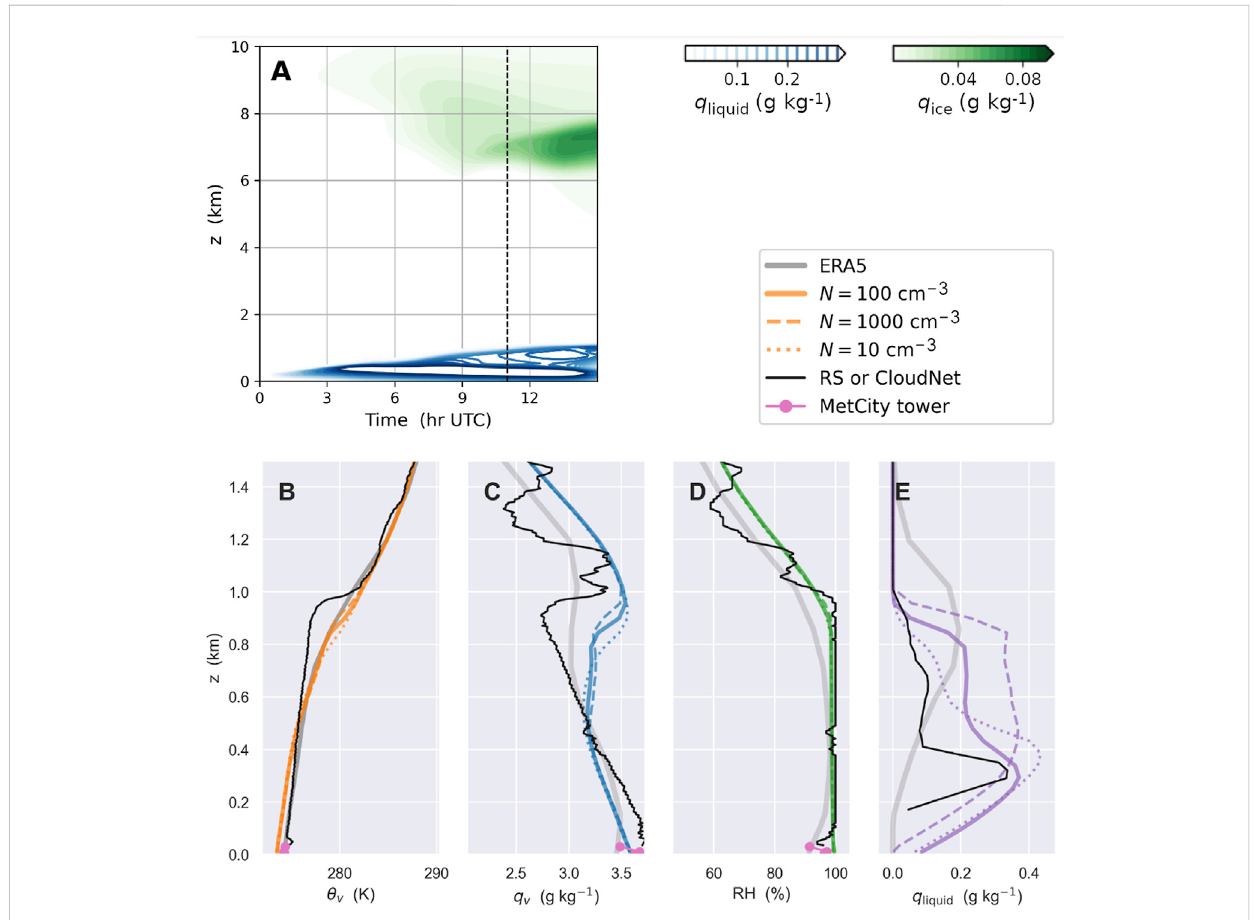
FIGURE 6 ResultsfromLagrangianLESsimulationswiththeDALEScodefor19April2020. Upperpanel:(A) Height-timecrosssectionsofcloudLWC(q liquid ,in blue) and IWC (q ice , in green). The dashed black line at 11 UTC indicates the air mass arrival time at RV Polarstern. Lower panels: Domain-averaged thermodynamicpro fi les at11UTC of (B) virtual potential temperature θ v , (C) water vapor speci fi chumidity q v , (D) relativehumidityRH and (E) cloud liquid waterspeci fi chumidity q liquid .ThreeLESexperimentsareshowninorange,with N indicatingtheinitialCCNconcentrationincm -3 (dashed,solidand dotted). The radiosonde (RS) and Cloudnet data are shown in black, the 10 m Met Tower data in pink, and ERA5 in